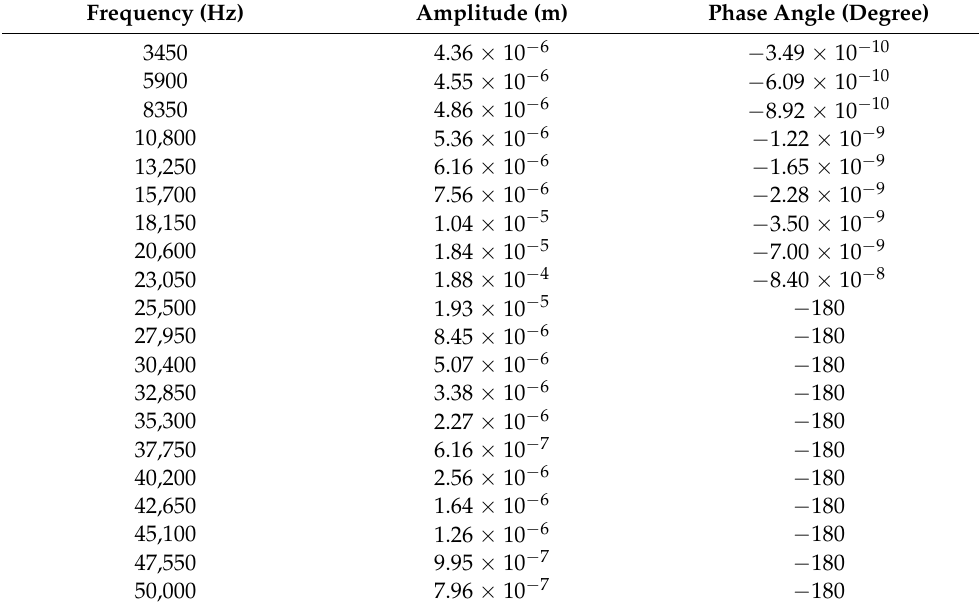
Table 7. Tabular form of the frequency